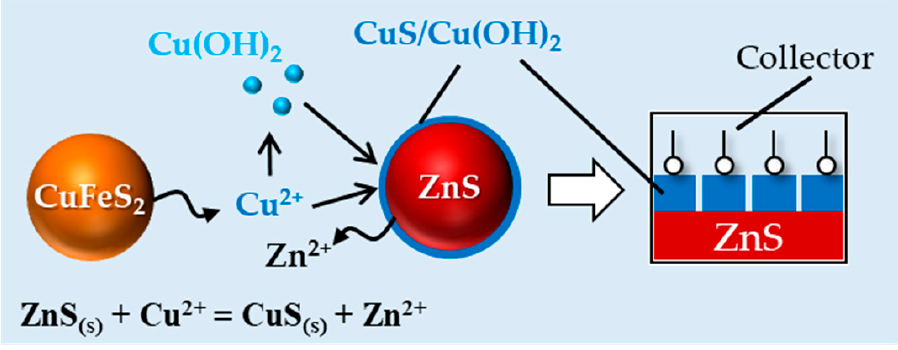
Figure 6. A schematic diagram of copper activation of sphalerite in the presence of chalcopyrite. To depress the floatability of sphalerite in the presence of chalcopyrite, the effect of zinc sulfate, a conventional depressant, on sphalerite floatability was investigated. Figure 7 shows the flotation results of chalcopyrite and sphalerite with and without 1 kg/t zinc sulfate. As illustrated in Figure 7a, sphalerite was recovered as froth together with chalcopyrite in the absence of zinc sulfate; however, when zinc sulfate was added as a depressant for sphalerite, the Zn recovery was dramatically decreased to ~12% even at 500 g/t PIPX (Figure 7b). Meanwhile, the floatability of chalcopyrite was not affected by zinc sulfate; >90% of Cu recovery was achieved irrespective of the presence of zinc sulfate at >50 g/t PIPX (Figure 7). These results indicate that zinc sulfate is effective in depressing the floatability of sphalerite even in the presence of chalcopyrite. The possible mechanisms of how zinc sulfate could depress the floatability of sphalerite in the presence of chalcopyrite are as follows: (i) adsorption of zinc precipitates such as Zn(OH) 2 on the surface of sphalerite, rendering the surface of sphalerite hydrophilic where the adsorption of the collector is limited, (ii) inhibition of Cu activation by zinc precipitates, and/or (iii) deactivation of Cu-activated sphalerite via reverse reaction of Equation (1) [29,33].